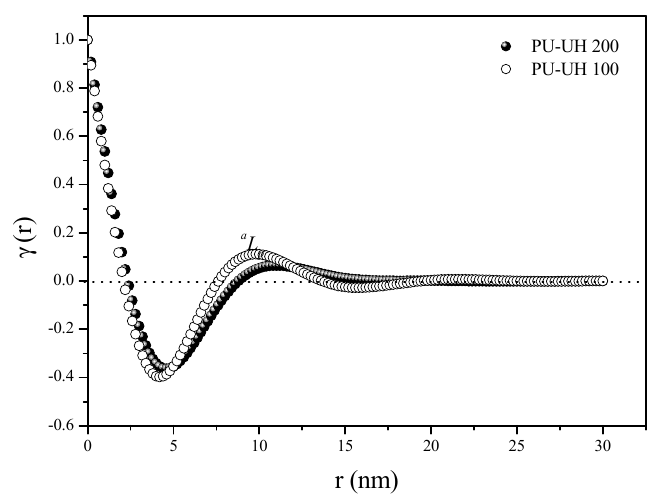
Figure 5. Example of correlation function for PU-UH.